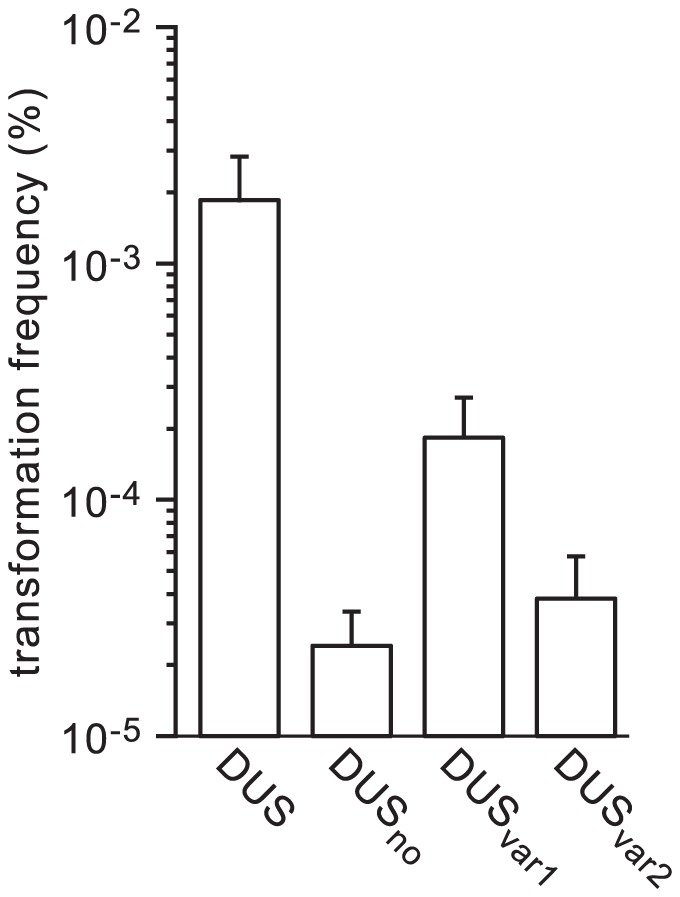
Naturally occuring DUS variants in human Neisseria commensals are impaired for enhancement of transformation in N. meningitidis.The ability of DUSvar1 and DUSvar2 to transform N. meningitidis 8013 was quantified using 100 ng of ΔpilN PCR fragments containing these DUS variants and compared to that of DUS and DUSno. Results are expressed as percentages of recipient cells transformed, and are the mean ± standard deviation of six to seven independent experiments.